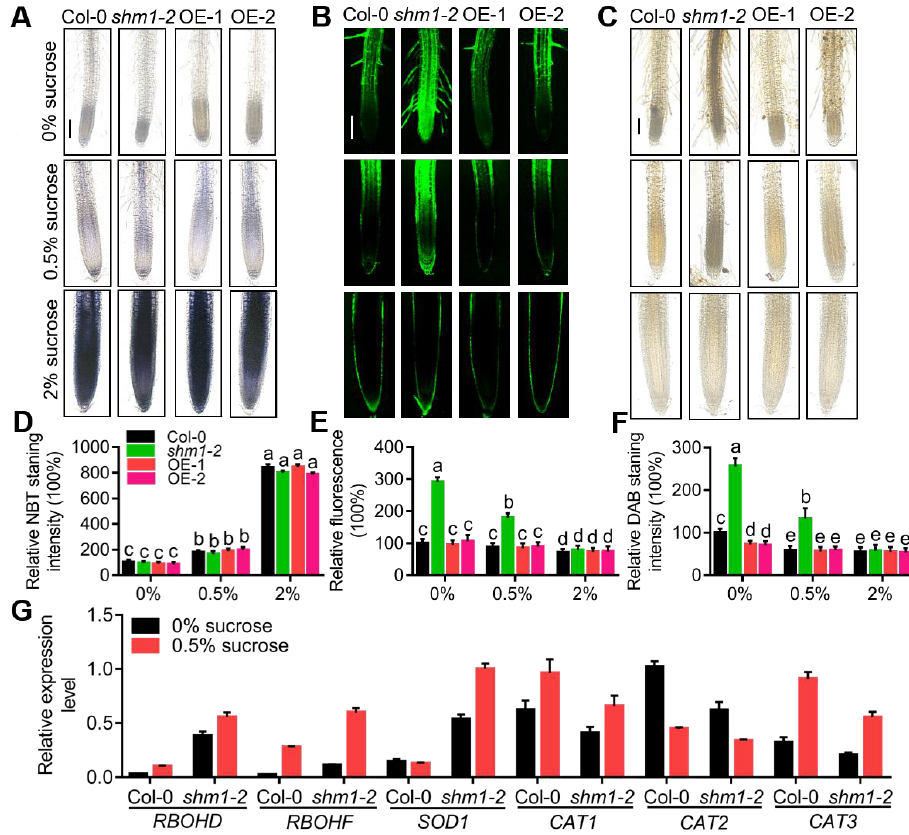
Figure 5. SHMT1 -expression changes altered H 2 O 2 accumulation in roots at low-sucrose conditions. ( A – C ) NBT staining for superoxide (O 2 − ) ( A ), H 2 DCFDA ( B ) and DAB staining ( C ) for H 2 O 2 in the primary roots of 8-day-old Col-0, shm1-2 and SHMT1 overexpression lines at 0%, 0.5%, and 2% sucrose conditions. Bars = 200 μm. ( D – F ) The NBT-staining intensity ( D ), fluorescence intensity ( E ), and DAB-staining ( F ) intensity in Col-0, shm1-2 , OE-1 and OE-2 at 0, 0.5%, and 2% sucrose conditions by ImageJ in ( A – C ), respectively. The intensity in Col-0 roots at sucrose-free conditions was set as 100%. In ( D – F ), data presented were means ± SEM, n = 3 experiments, each with 10 roots per experiment. Different letters above error bars indicated significant difference at p < 0.05, using two-way ANOVA with Tukey’s test. ( G ) Quantitative PCR analyses of H 2 O 2 -producing genes ( RBOHD , RBOHF , SOD1 ) and scavenging genes ( CAT1 , CAT2 , CAT3 ) in 8-day-old seedlings of shm1-2 and Col-0 at 0%, 0.5% sucrose conditions. Data presented were means ± SEM, n =